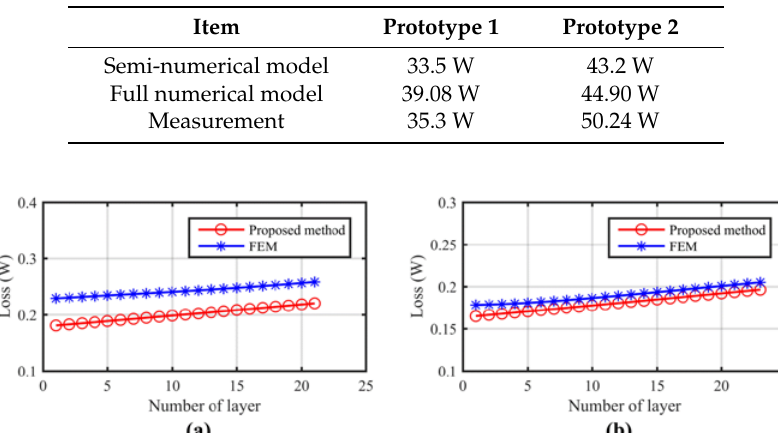
Table 5. Comparison of modeled winding losses and measurements.